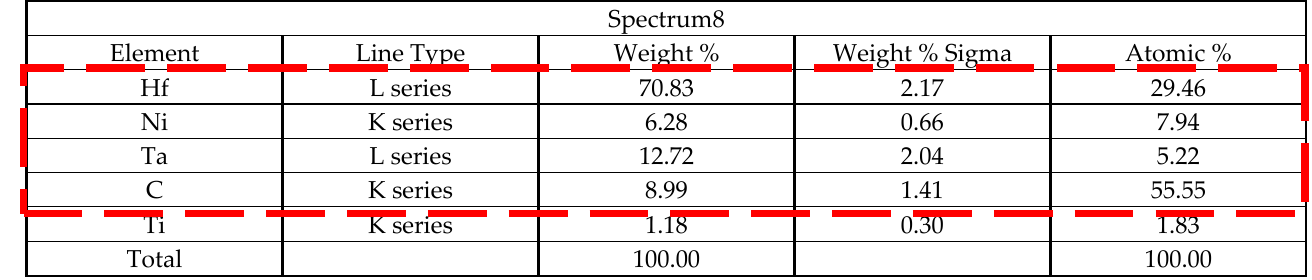
Figure 3. ( a ) Grain growth direction in the cross selection of the grain selector; ( b ) grain boundary element distribution of the alloys.